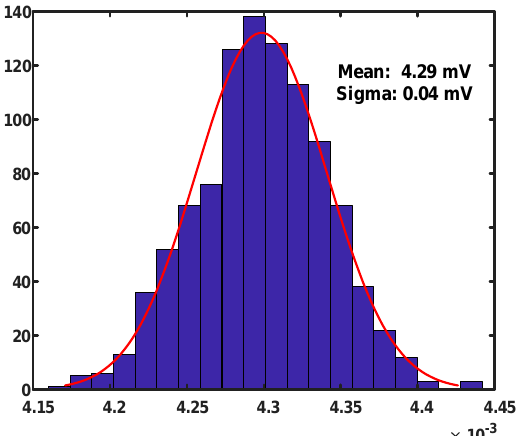
Figure 4. Monte Carlo simulation of the calibration voltage due to the mismatch of the resistors .